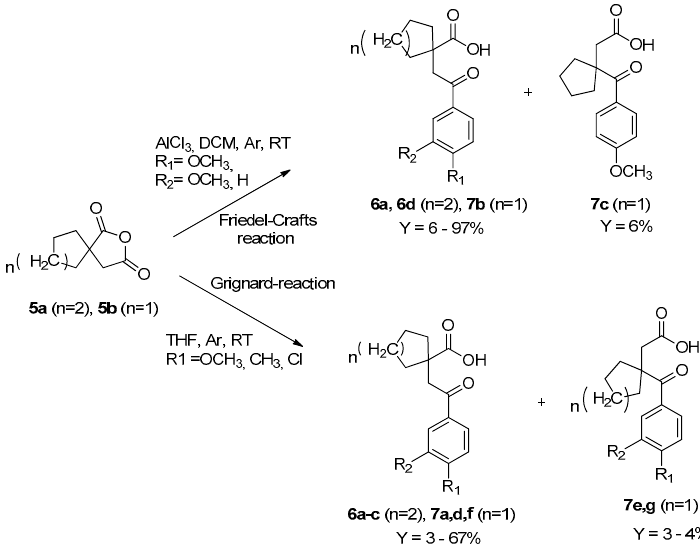
Table 1. Fsp 3 values of γ -oxocarboxylic